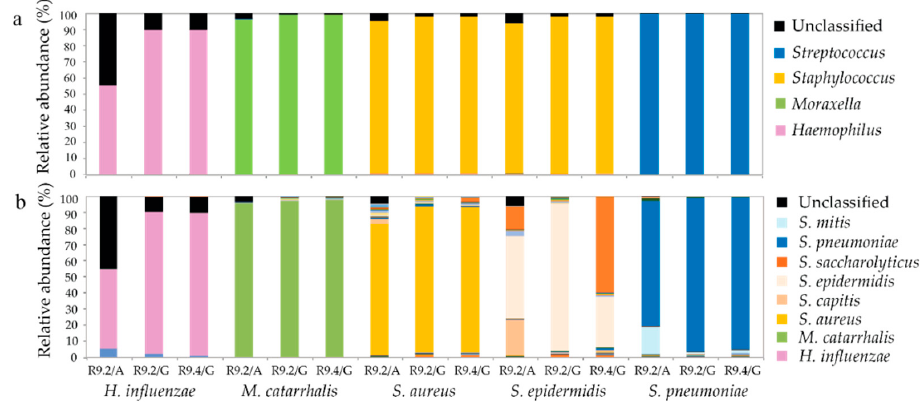
Figure 4. Genus and species level identification on pure culture species. Pure cultures of bacterial ATCC strains were sequenced using an R9.2 or R9.4 nanopore flowcell and Albacore or Guppy basecalling. Taxonomic assignment was performed at genus ( a ) and species ( b ) level using the EPI2ME 16S pipeline and the following thresholds: read length ≥ 1400 bp ≤ 1700 bp, num_genus_taxid is 1 or lca is 0 and accuracy ≥ 80%, QC ≥ 7 when albacore basecalling was used, or accuracy ≥ 85%, QC score ≥ 9 when Guppy basecalling was used. Similar criteria and the highest scoring BLAST identification (top rank) was used for species level identification. A is Albacore; G is Guppy basecalling.